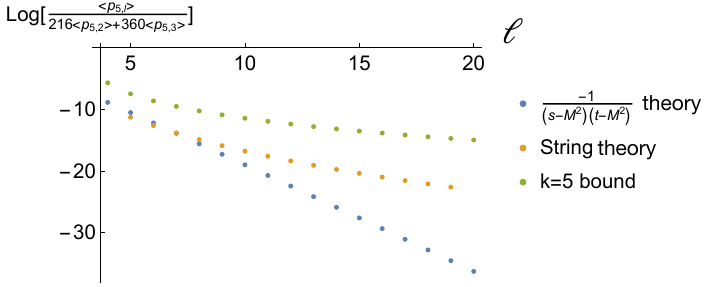
Figure 9 . Here we present the k = 5 bounds in the s -EFThedron ((5.30)) & ((5.32)) with the and the Type-I open string S -matrix − 1 ( s − M 2 )( t − M 2 )